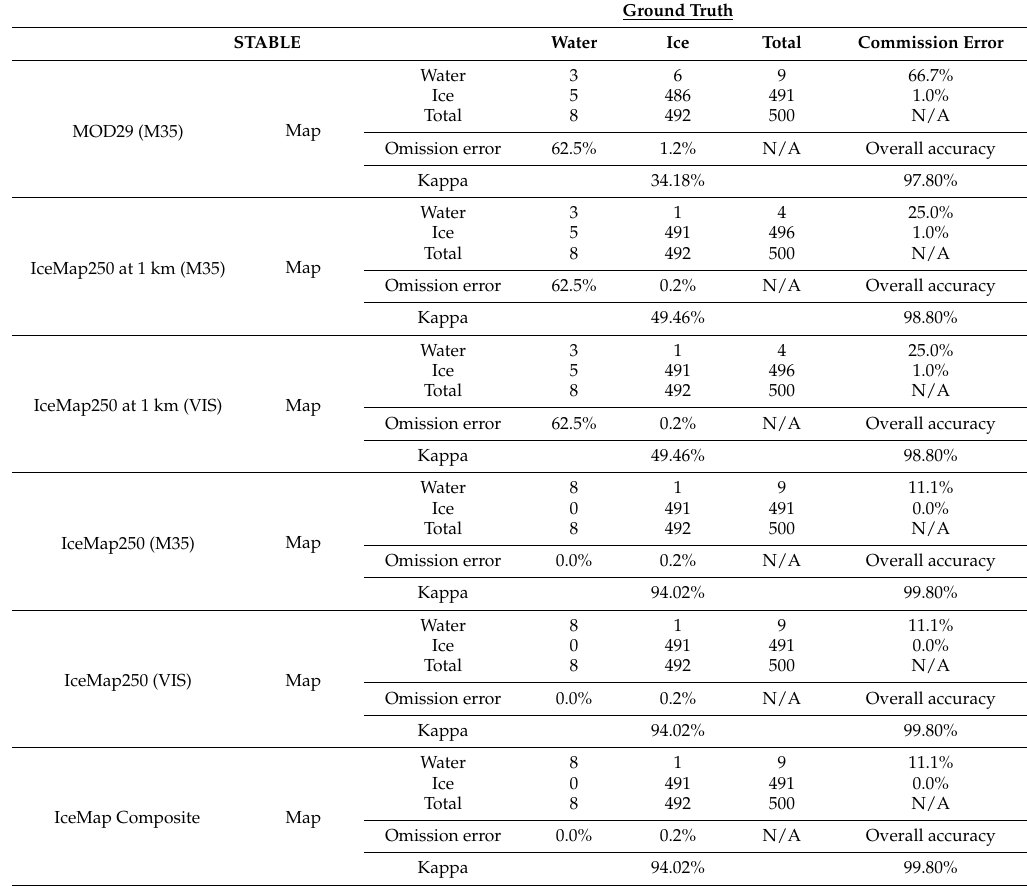
Table 4. Contingency table for the stable period validation (10 February 2016 to 20 February